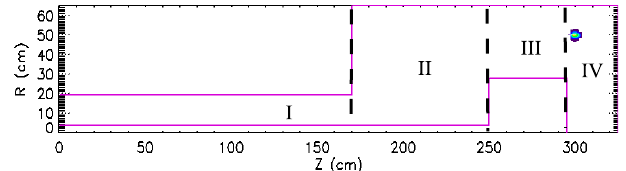
FIG. 12. (Color) Idealized representation of the RITS-6 dustbin and knob used in calculations of cavity resonant modes. The four labeled subregions were used in the semianalytic model. A dipole current source located at r (cid:4) 50 and z (cid:4) 300 cm was used to obtain numerical solutions using L SP .